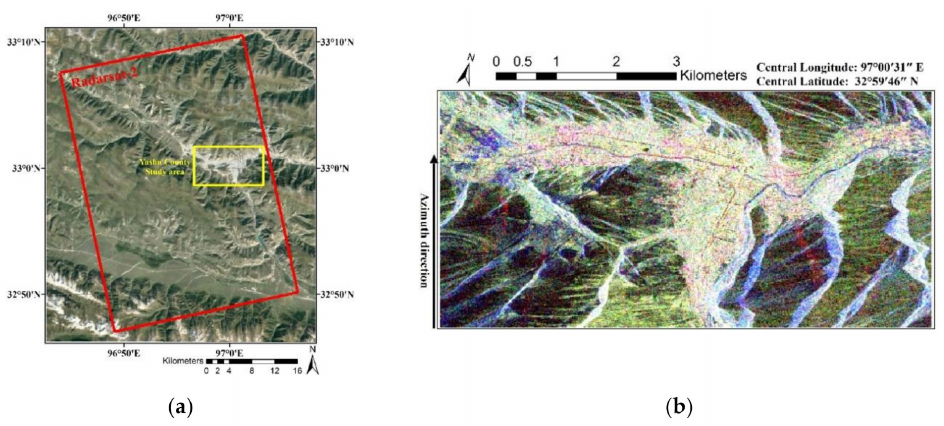
Figure 1. The basic information of the Radarsat-2 fully polarimetric synthetic aperture radar (PolSAR) data in the Yushu study site: ( a ) Google Earth image, showing the coverage of the PolSAR data (red rectangle) and the location of Yushu County (yellow rectangle); ( b ) the Pauli RGB image of the PolSAR